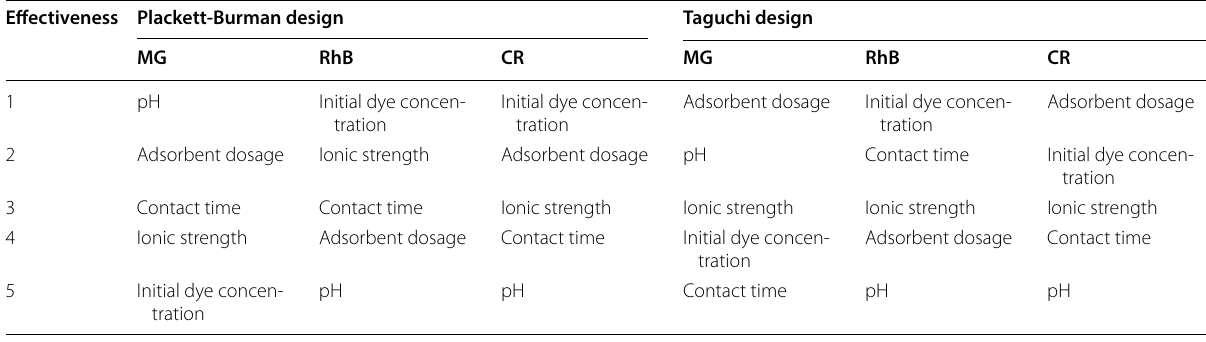
Table S5 are the values of the above parameters. It is